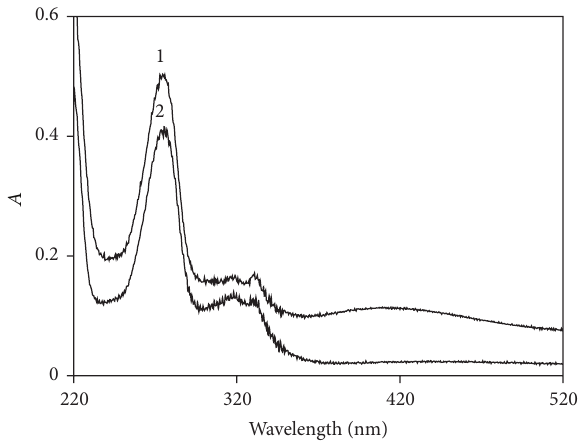
Figure 3: UV-vis absorption spectra. (1) Silver nanoparticles- Tb(III)-PFLX; (2) Tb(III)-PFLX. Conditions: silver nanoparticles, 5.0 × 10 −6 M; Tb(III), 2.0 × 10 −4 M; PFLX, 1.0 × 10 −6 M.